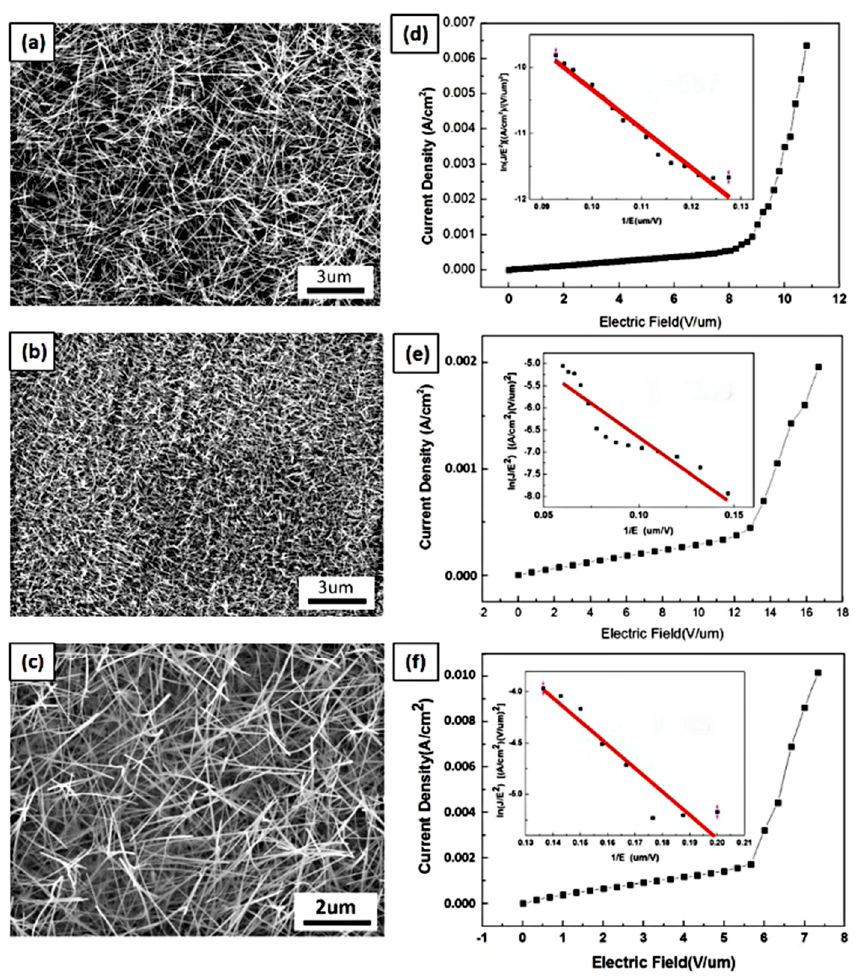
Figure 7. SEM images and fi eld emission measurements of WO 3 NWs. ( a , d ) NWs grown at 750 °C. ( b , e ) NWs grown at 650 °C. ( c , f ) K-doped NWs grown at 750 °C. Table 1. Comparison of the fi eld emission properties of WO 3 nanowires with previous studies.